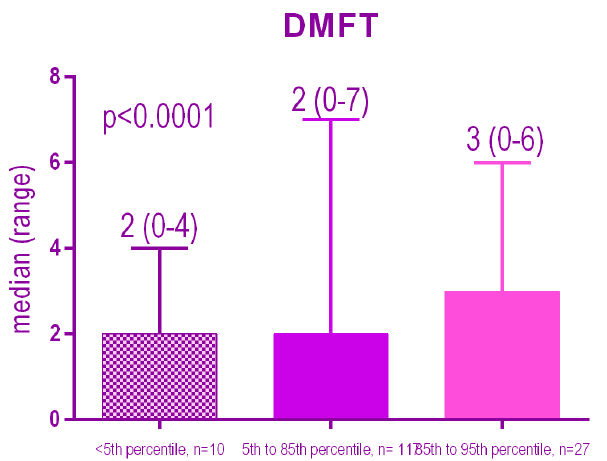
Figure 2. Distribution of the DMFT index according to the BMI percentile. There is a highly significant association ( p < 0.0001) between the BMI percentile and the dmft number. Patients with a high BMI percentile have a significantly higher dmft compared to other groups of patients.